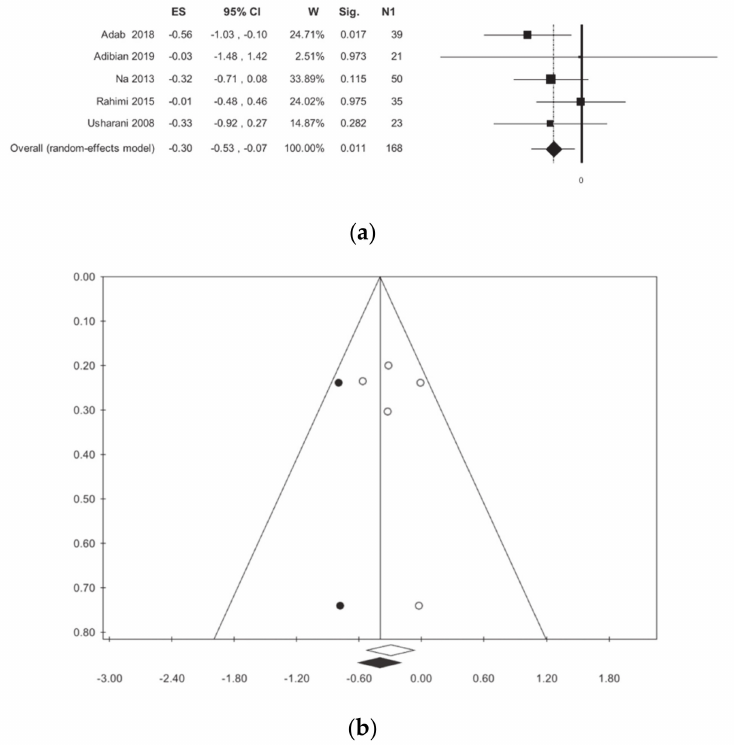
Figure 8. Meta-analysis results according to Total Cholesterol: ( a ) forest plot ( b ) funnel